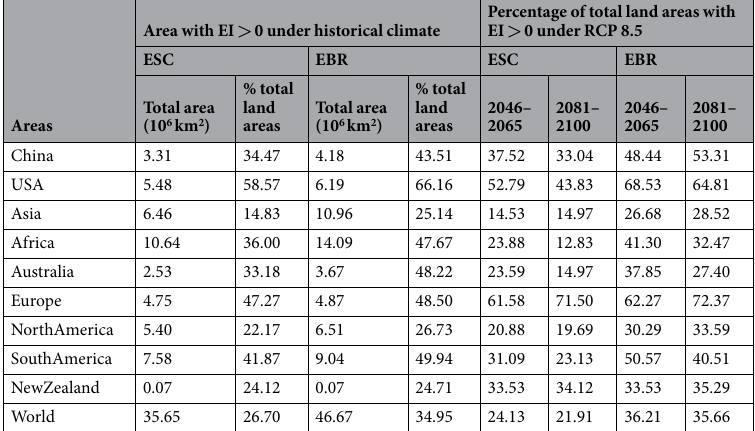
Table 1. The climatically suitable area (EI > 0) on each continent for ESC and EBR under the historical climate, expressed as an area (10 6 km 2 ) and as a percentage of the total land area per country or region, and the percentage change in the middle and latter of the 21st century under future climate change scenario RCP 8.5.